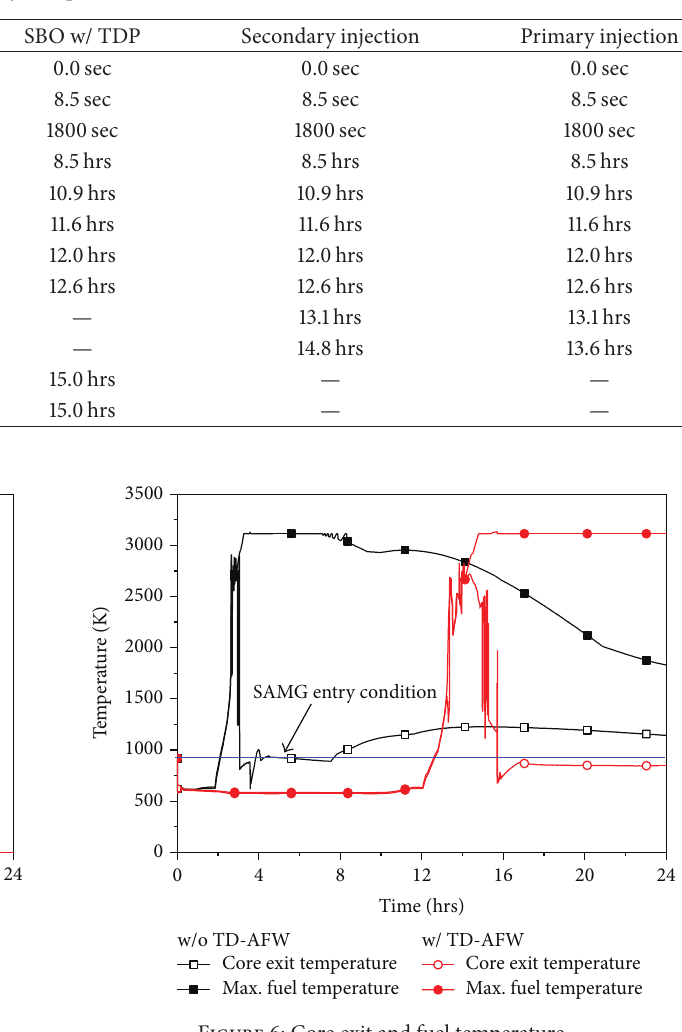
Table 3: Major sequences of events.